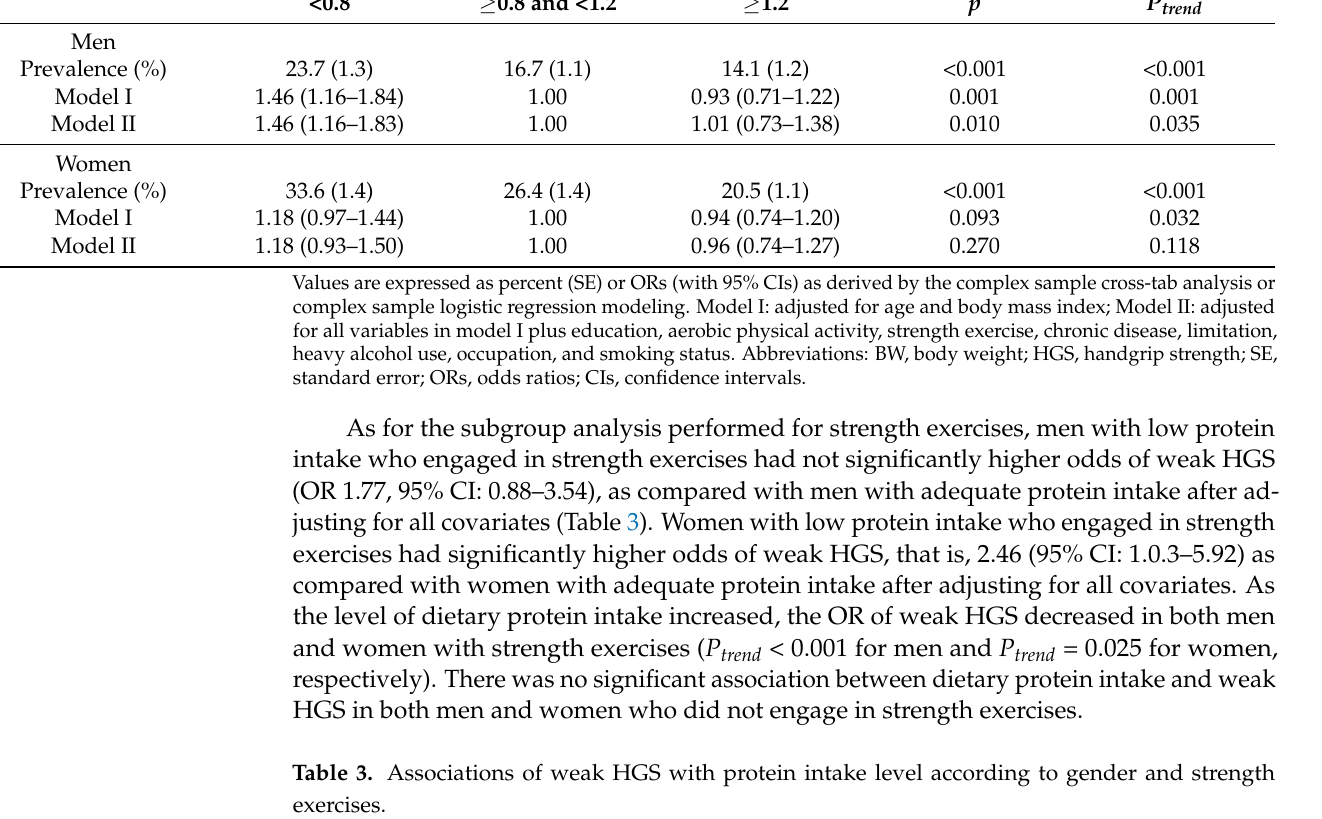
Table 2. Association of weak HGS with protein intake level according to gender. Protein Intake Per kg BW